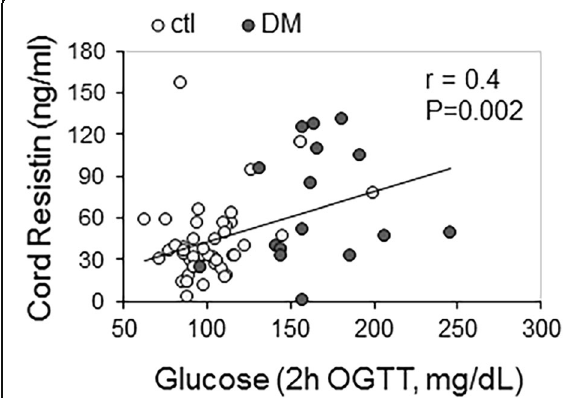
Fig. 2 Correlation between cord blood human resistin and maternal blood glucose levels during pregnancy. Cord blood resistin levels were determined as described in methods. Maternal glucose